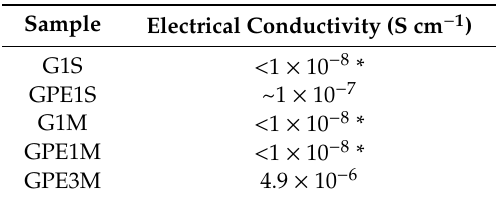
Table 5. Electrical conductivity measured by four-probe technique, for all samples prepared in this